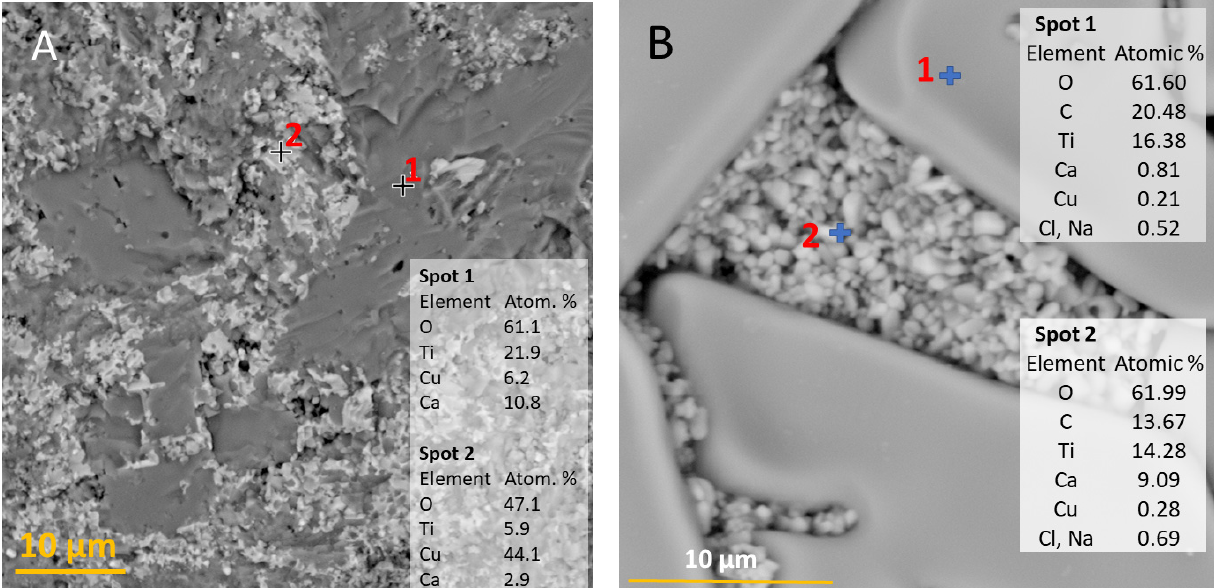
Figure 6. SEM-BSE micrograph of machined, but not polished surface ( A ) HPF sample F (1050 °C, 120 min); ( B ) SPS sample A (SPS at 900 °C, non-annealed).